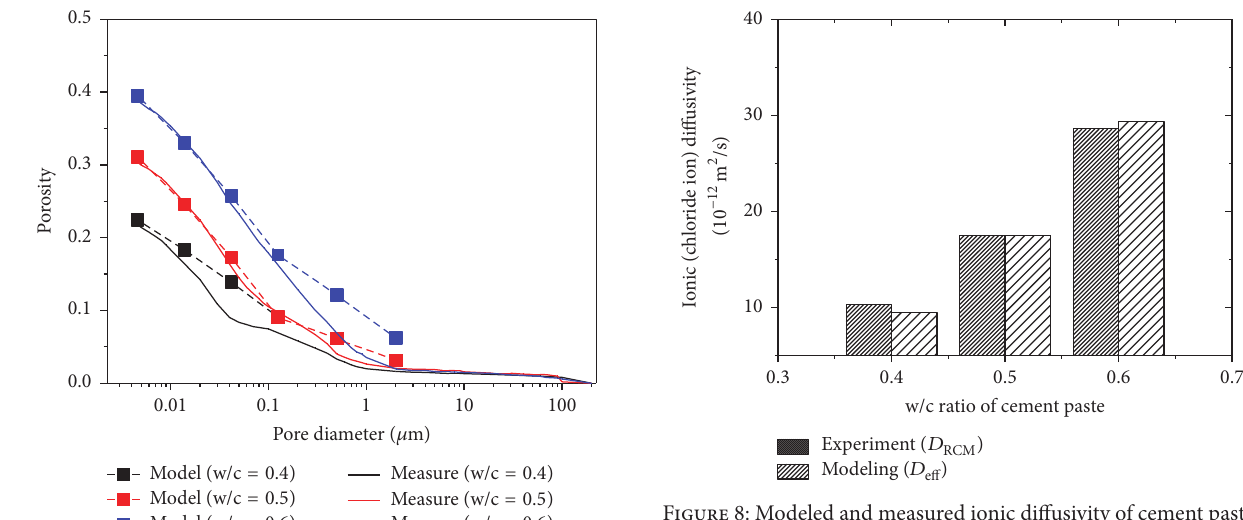
Figure 8: Modeled and measured ionic diffusivity of cement pastes with varying w/c